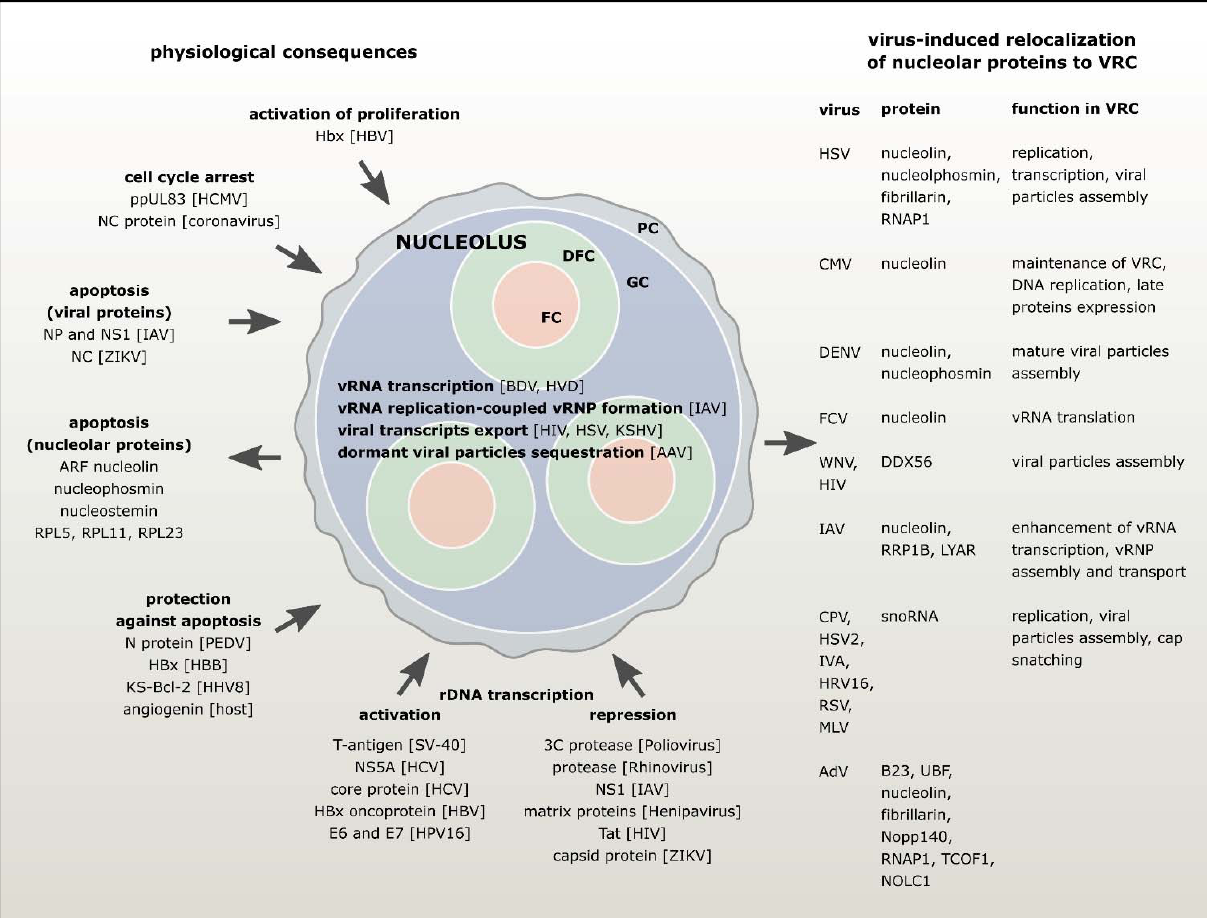
Figure 1. Nucleolus interface in the course of viral infection.